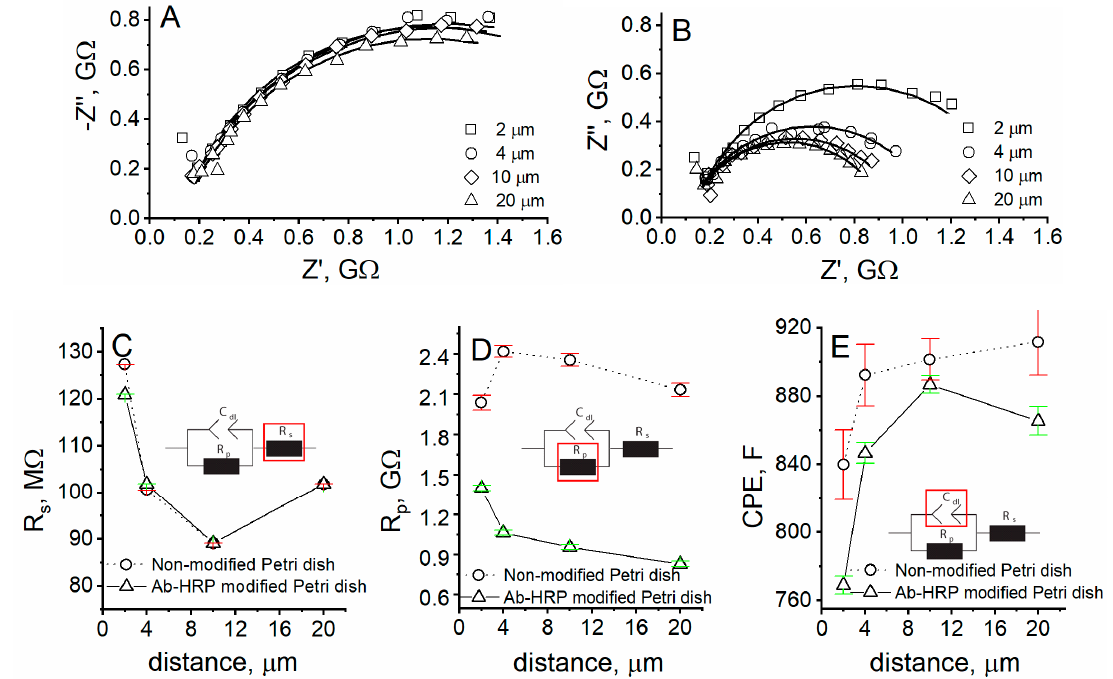
Figure 3. Nyquist plots of experiments performed at different distances from ( A ) unmodified and ( B ) Ab-HRP-modified Petri dishes in APBS with 1 mM solution of K 3 [Fe(CN) 6 ]/K 4 [Fe(CN) 6 ] using 4.2 mM H 2 O 2 concentration; dependence of ( C ) resistance of solution, ( D ) resistance of charge-transfer, ( E ) double-layer capacitance on distance between the UME and surface of Petri dish.